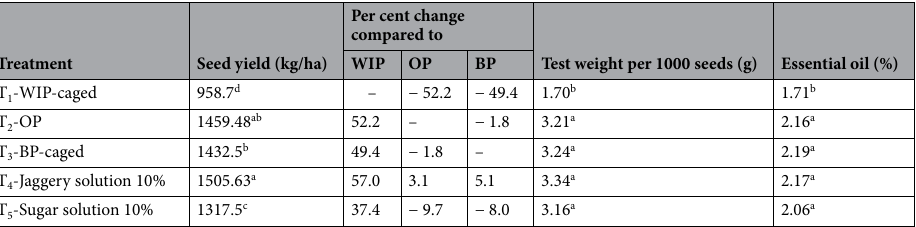
Table 4. Effect of different modes of pollination on yield and quality of dill seeds in semi-arid region during winter cropping season. The data given in the table are pooled of 2 years research (2016–17 & 2017–18); values are average of 4 replications. WIP without insect pollination, OP open pollination, BP bee pollination is not all bees pollination but just honeybee pollination. Averages followed by the common letters in a column are not statistically different at (P ≤ 0.05) according to Duncan’s multiple range test